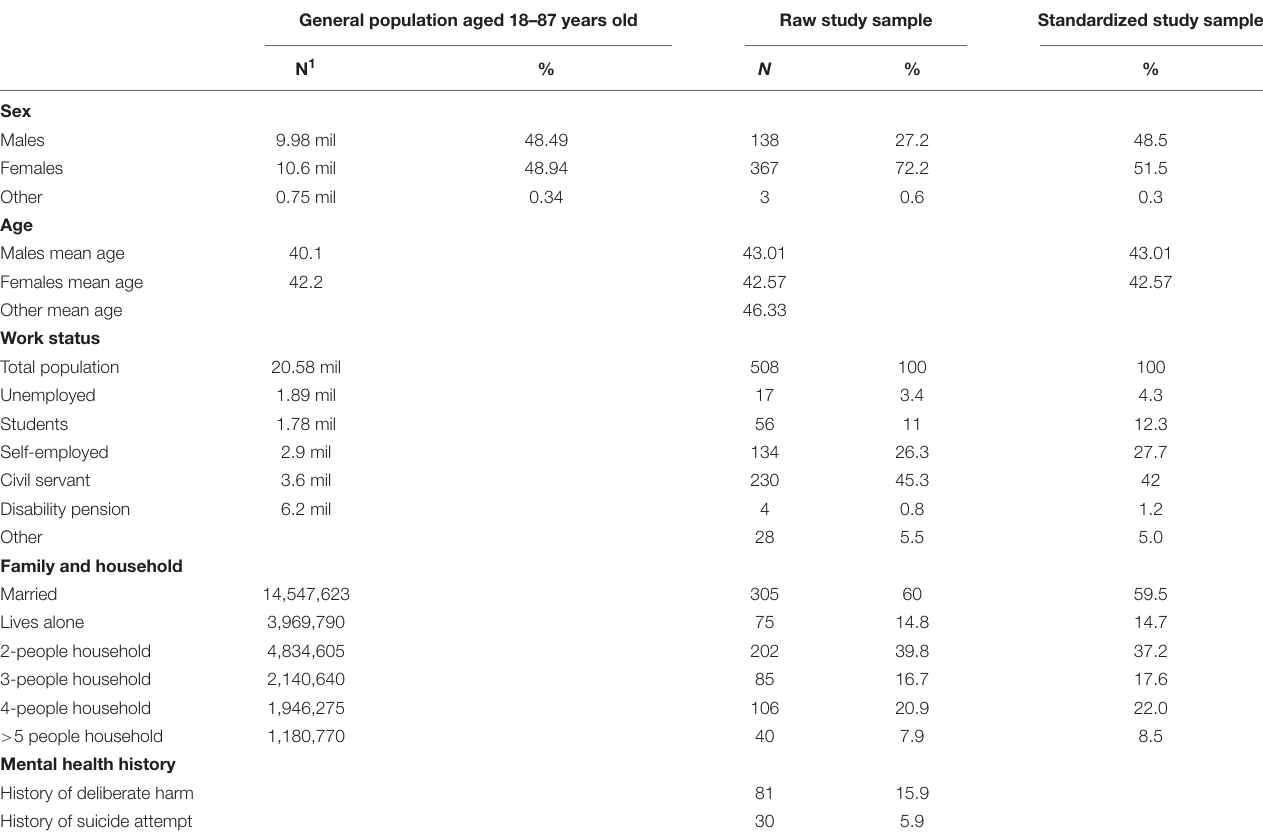
TABLE 1 | Descriptive statistics of the original (raw) and the standardized study samples in comparison to the general